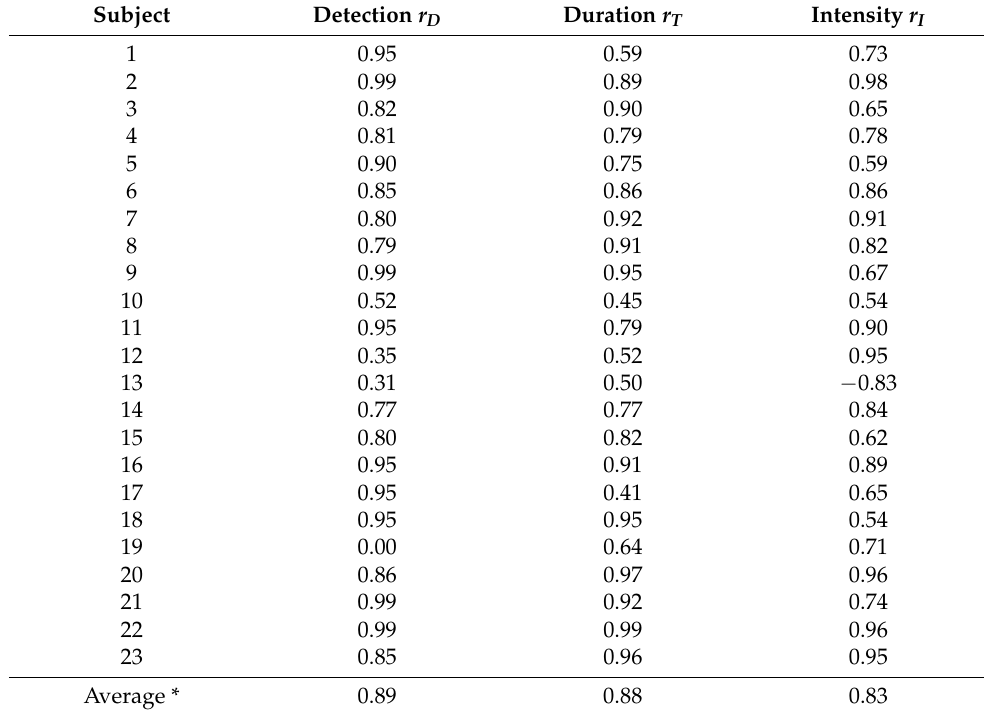
* Computed with the Fisher z ‐ transformation method, weighted on the number of events per sub ‐ ject.